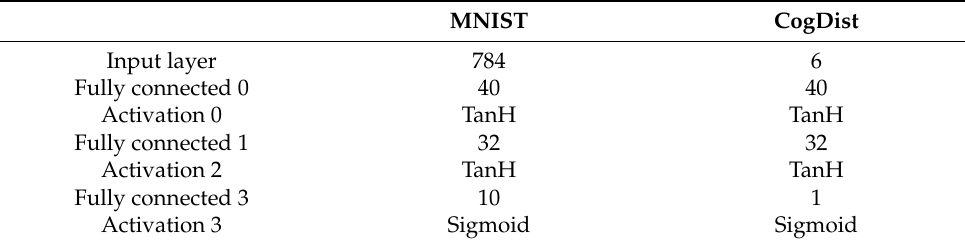
Table 5. Baseline ANNs for evaluation: number of neurons per layer and activation.